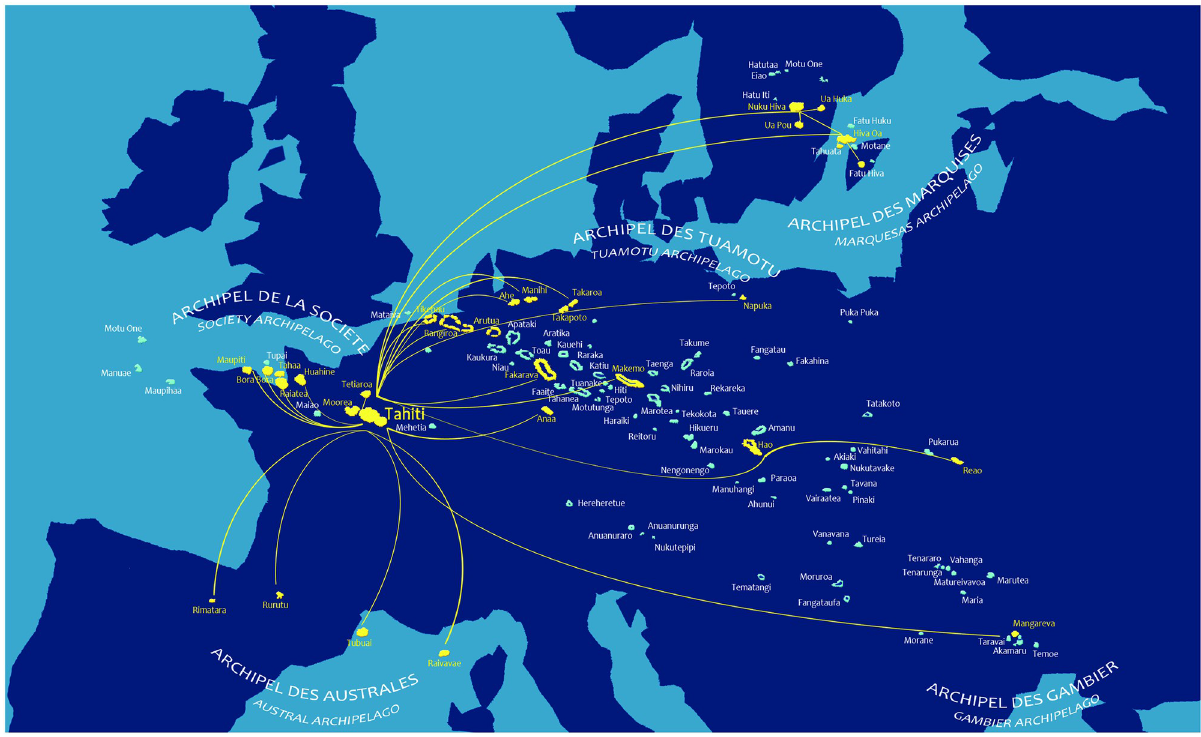
Fig 1. Air and maritime connections for the shipment of travelers’ self-collected samples from the islands with health care centers participating in the COV-CHECK PORINETIA surveillance strategy, to Tahiti where the Institut Louis Malarde´ is located; a surface area as wide as Europe.